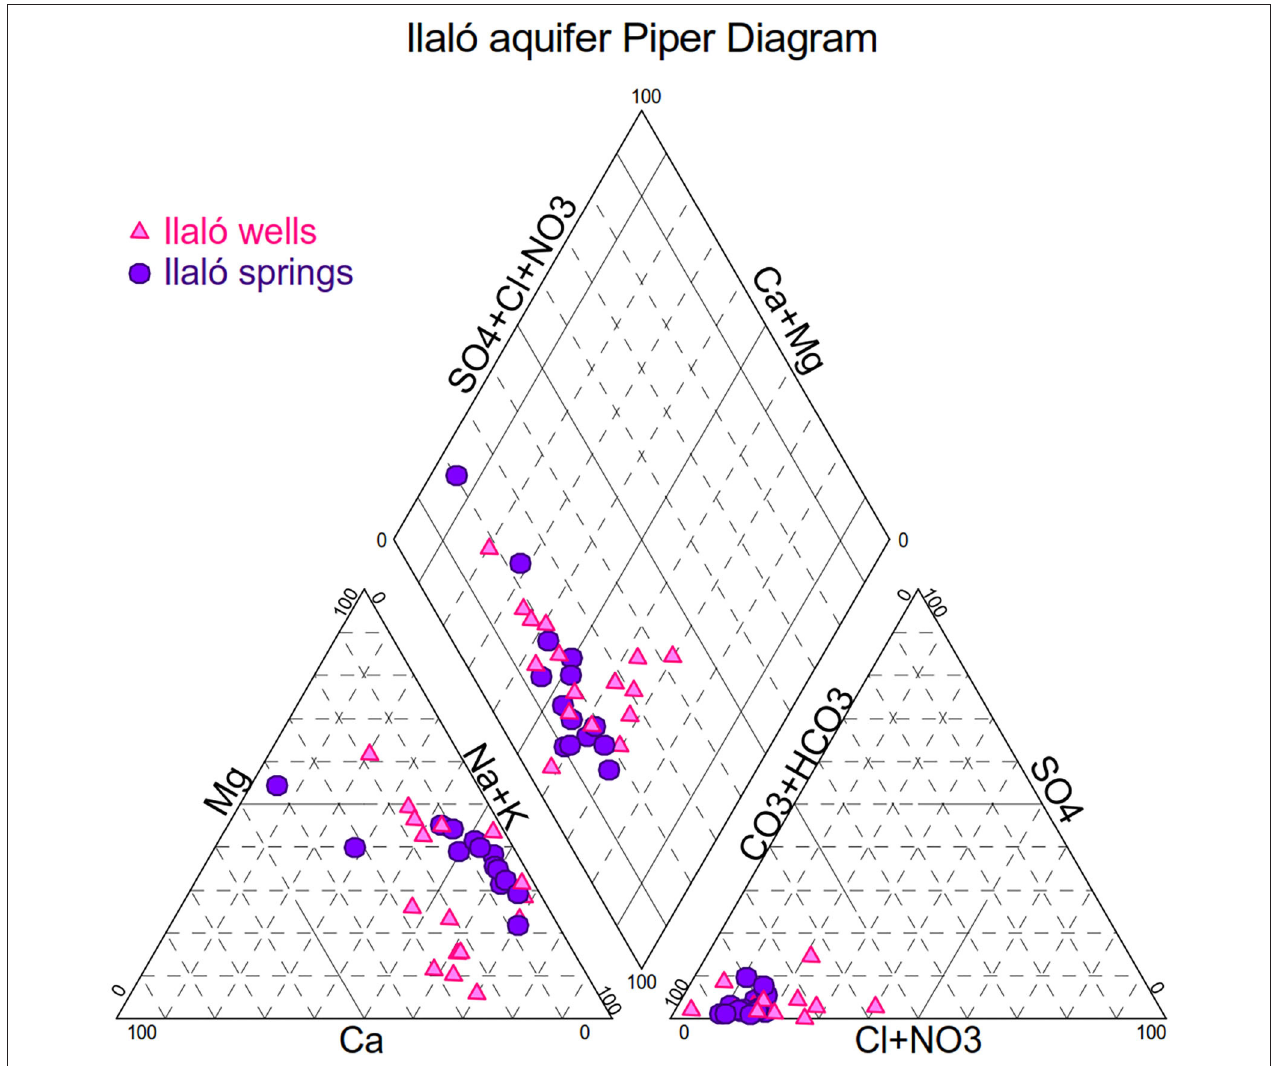
FIGURE 6 | Ilaló aquifer Piper